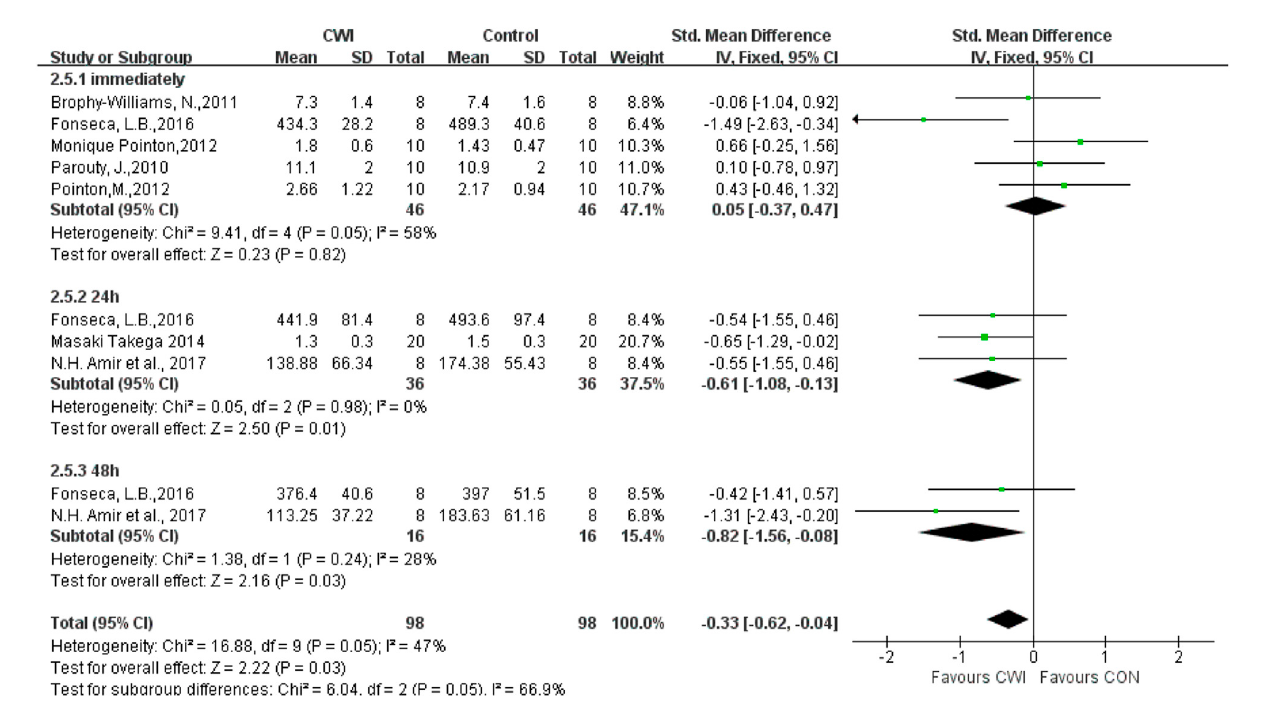
FIGURE 8 Forest plot of the comparison of CWI versus CON for measurement of Lactate. CWI = Cold water immersion, CON =